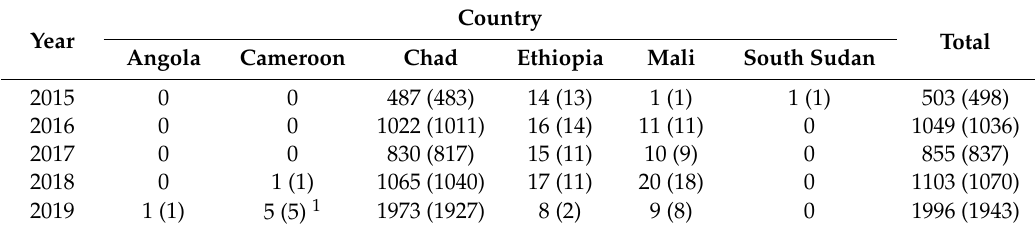
Table 2. Reported Animal Infections of Guinea Worm Disease in Considered Countries, 2015–2019; (Canine Infections).